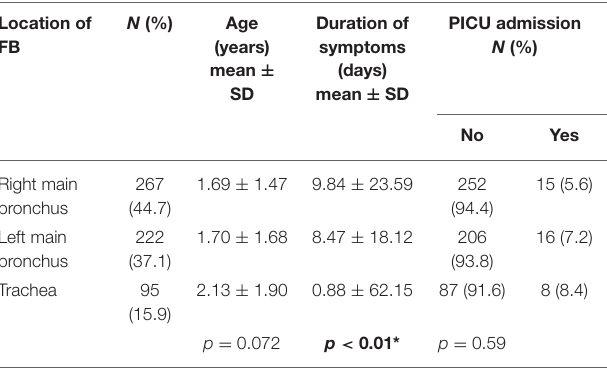
TABLE 1 | Age, duration of symptoms, and Pediatric Intensive Care Unit (PICU) admission by location of foreign